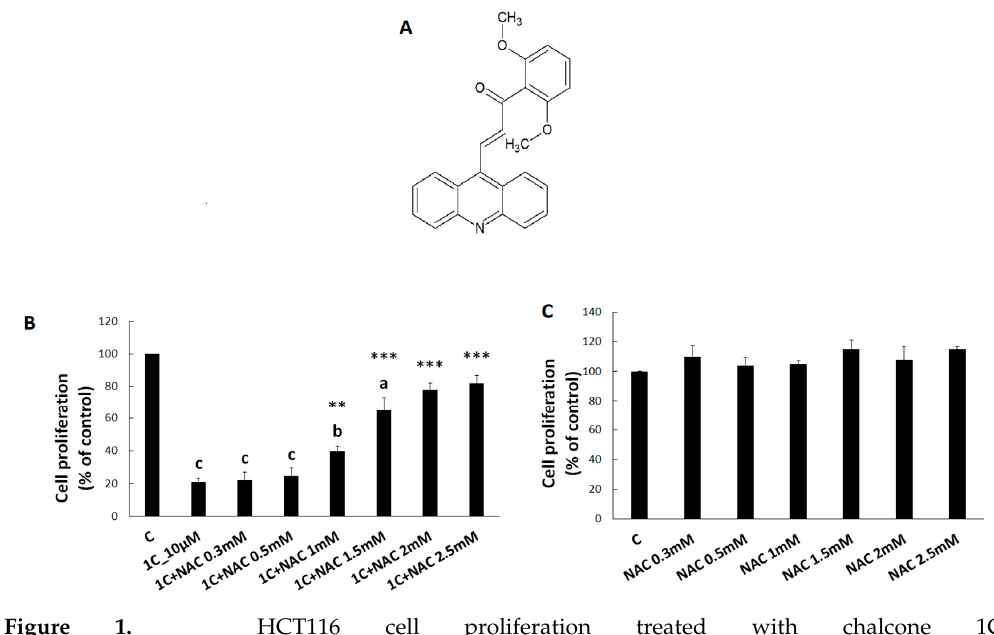
Figure 1. HCT116 cell proliferation treated with chalcone 1C ((2 E)-3-(acridin-9-yl)-1-(2,6-dimethoxyphenyl)prop-2-en-1-one) alone ( A ) or in combination ( N -acetyl cysteine (NAC)/1C) ( B ) and after NAC dilutions ( C ). Data were obtained from three independent measurements. Significantly different a p < 0.05, b p < 0.01, c p < 0.001 vs. untreated cells (control); ** p < 0.01, *** p < 0.001 vs. 1C.